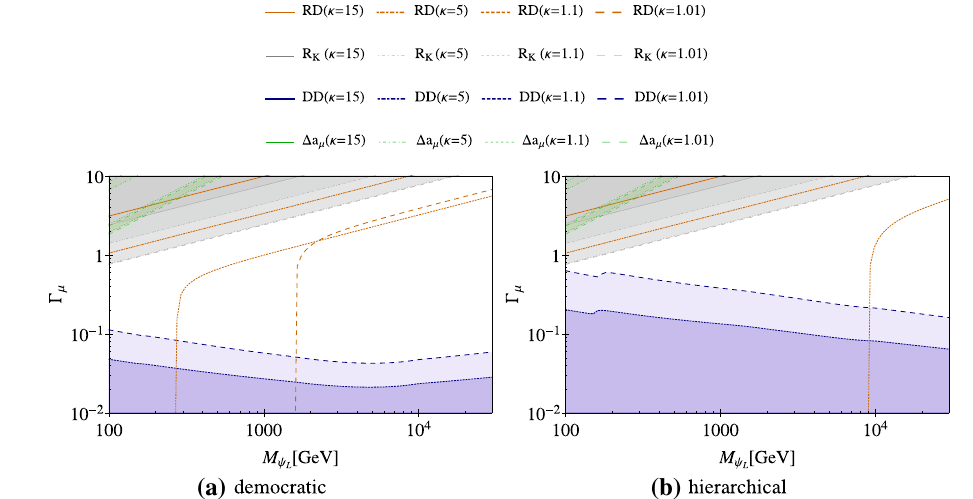
( a ) (b) Fig. 4 Summary plot for Dirac DM in bIIA. The plot provides the produced to the right. The gray region displays the region where the R K implications on the parameter space of the relic density (RD), the R K anomaly can be addressed at 2 σ . The blue region indicates the parame- ter space allowed by direct detection experiments including both SI and observable ( R K ), direct detection (DD) and the anomalous magnetic SD constraints. Lastly, the green regions show areas where Δ a μ can be moment of the muon ( Δ a μ ) for κ = 1 . 01 (dashed line), κ = 1 . 1 (dotted line), κ = 5 (dot-dashed line) and κ = 15 (solid line). The orange lines reproduced at 1 σ . The area above the green bands lead to overly large give the parameters that generate the observed relic density. Parameter contributions to Δ a μ and is therefore points to the left of those lines underproduce DM, while DM is over-